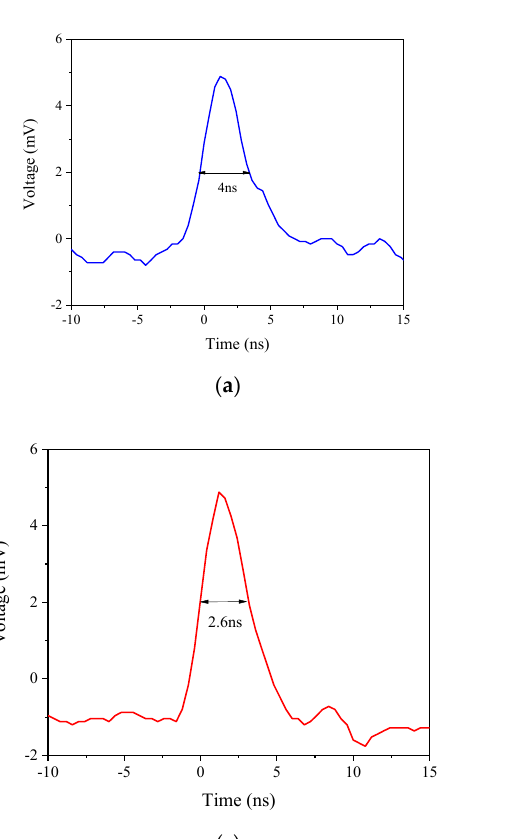
Figure 8. The output power characteristics of the FGRL with different repetition frequencies (pulse width 4 ns). ( a – c ) The Raman power, residual pump power and Raman efficiency, respectively. ( d ) The Stokes pulse energy with coupled pump pulse energy in different repetition frequency.